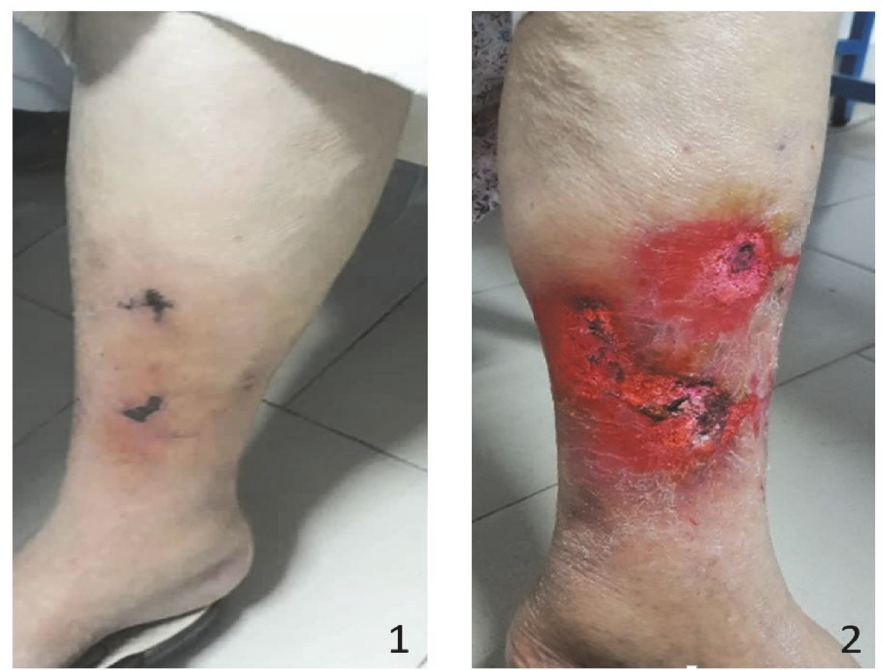
Figure 3: Calciphylaxis lesions at the admission of patient 2 (A: right leg, B: left